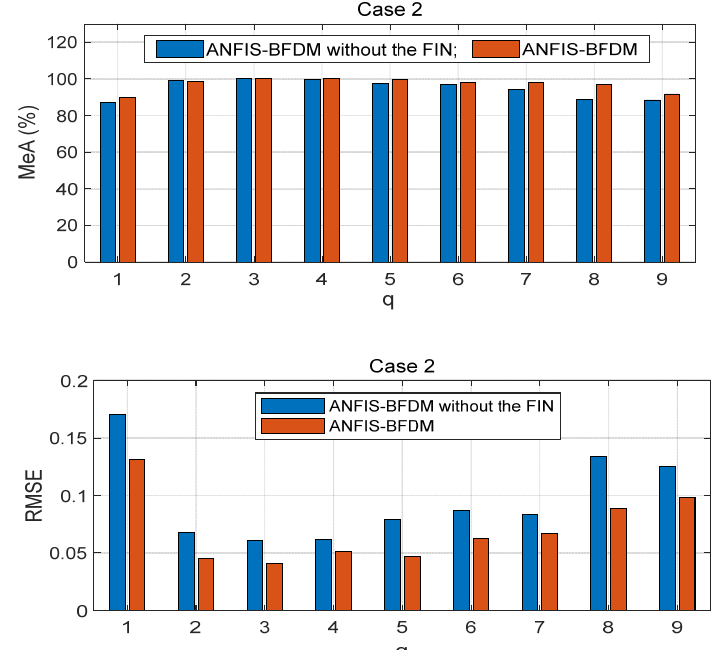
Figure 4. “Case 2”—the positive role of the FIN expressed by the MeA and RMSE of the ANFIS-BFDM via the two cases, with/without r(t) when q = 1 … 9.